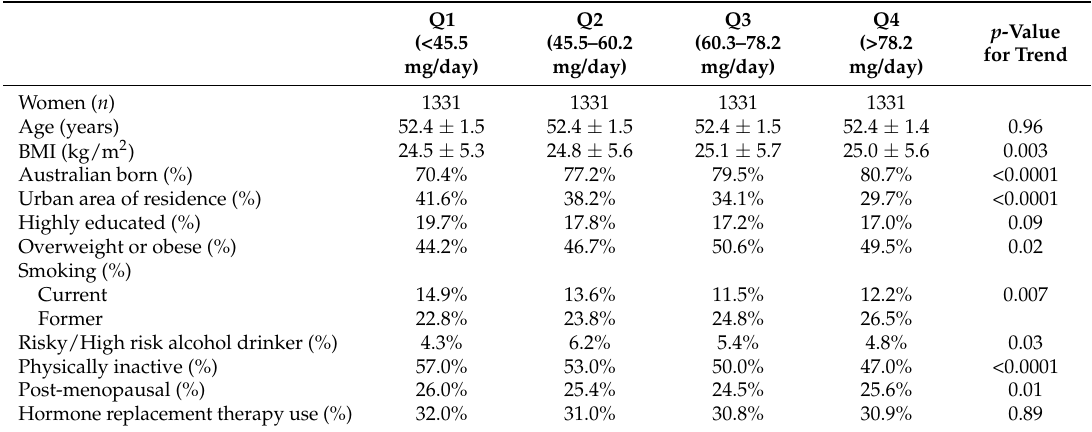
Table 1. Baseline characteristics of all study participants by quartile for total dietary nitrate intakes.